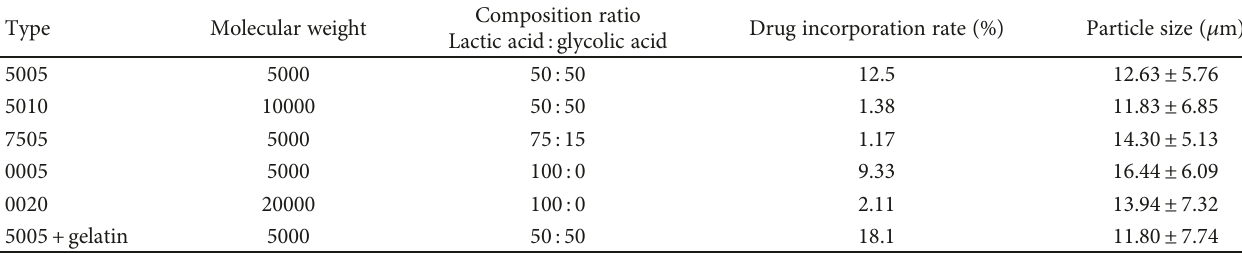
Table 1: Summary of poly lactic/glycolic acid (PLGA) or poly lactic acid (PLA)